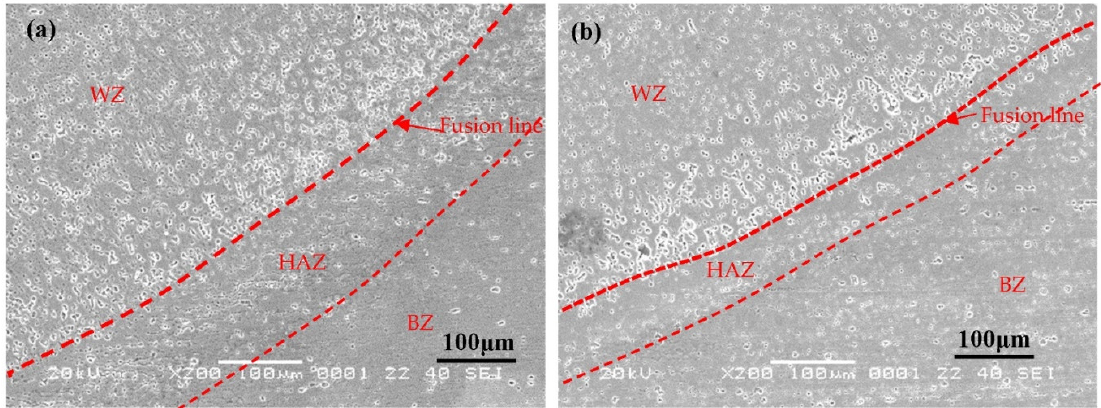
Figure 5. SEM image of the cover layer in two welded joints, ( a ) ER5356, ( b ) ER5087.